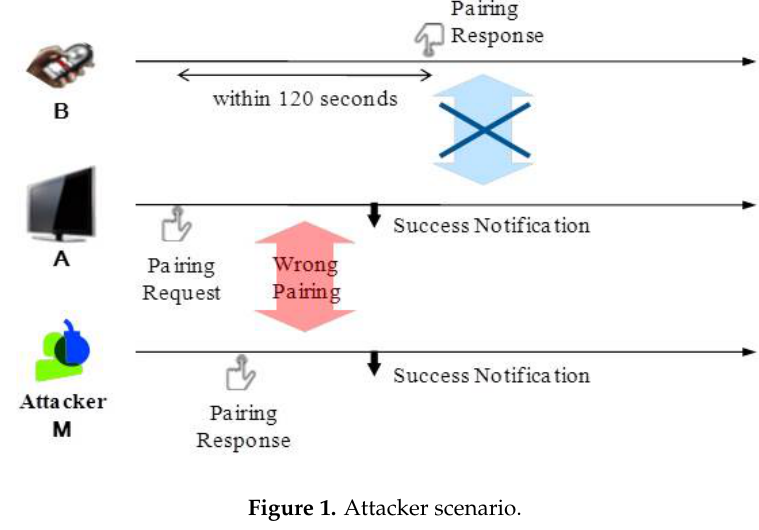
Figure 1. Attacker